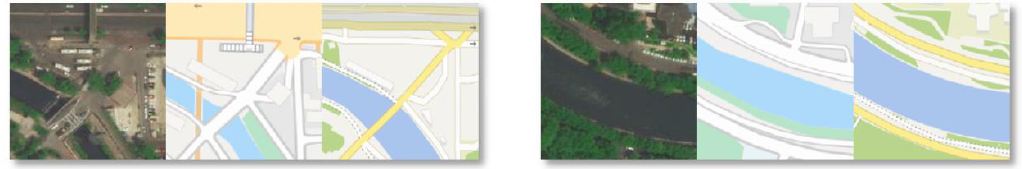
Figure 6. Two training samples in the dataset we made for the one-to-many domain map generation task. Each training sample contains three images; from left to right are the remote sensing image, Baidu map, and Map World map.